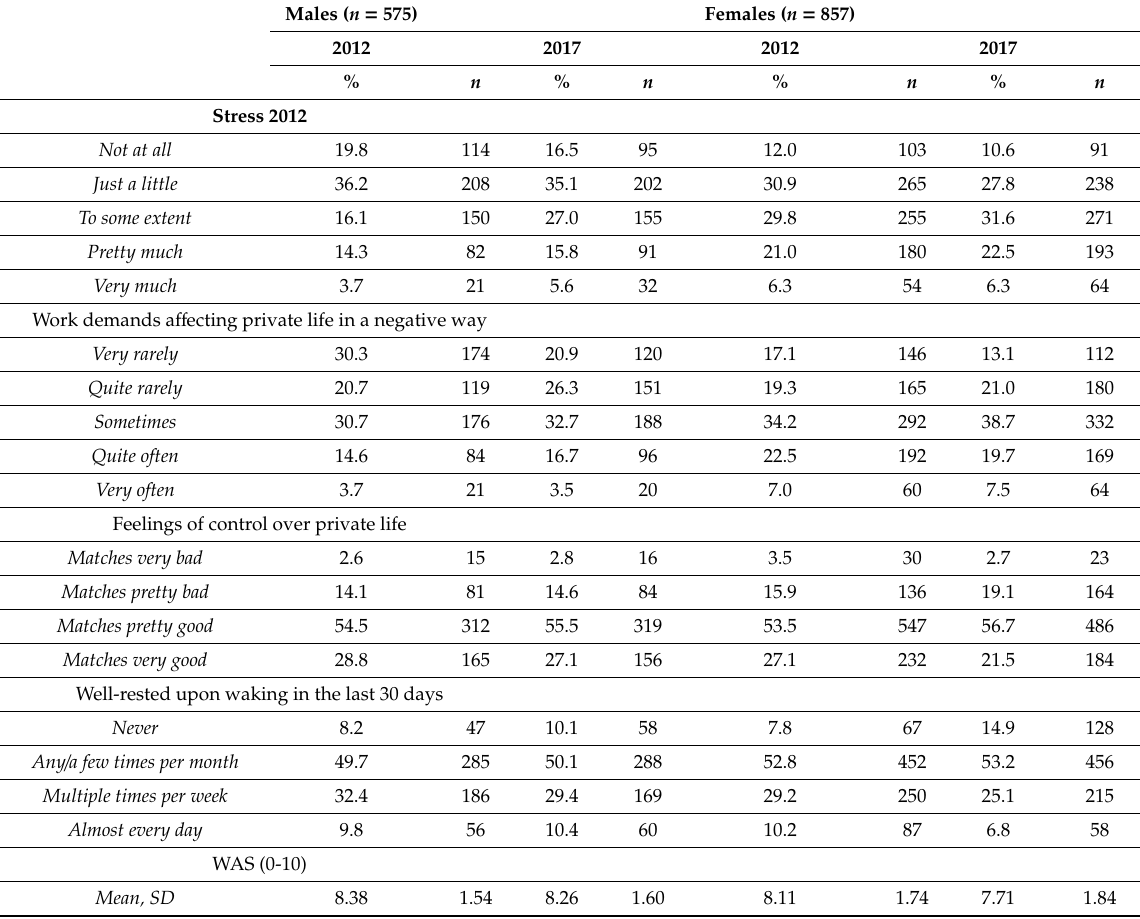
Table A5. Descriptive statistics of mediator variables for males and females in 2012 and